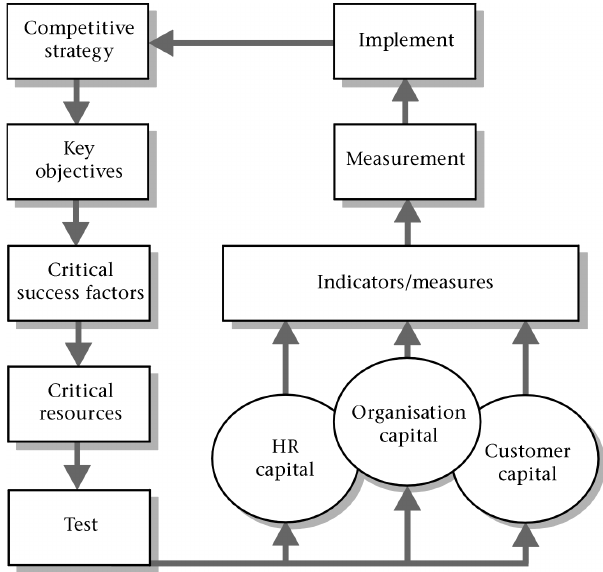
Figure 3: IC Assessment